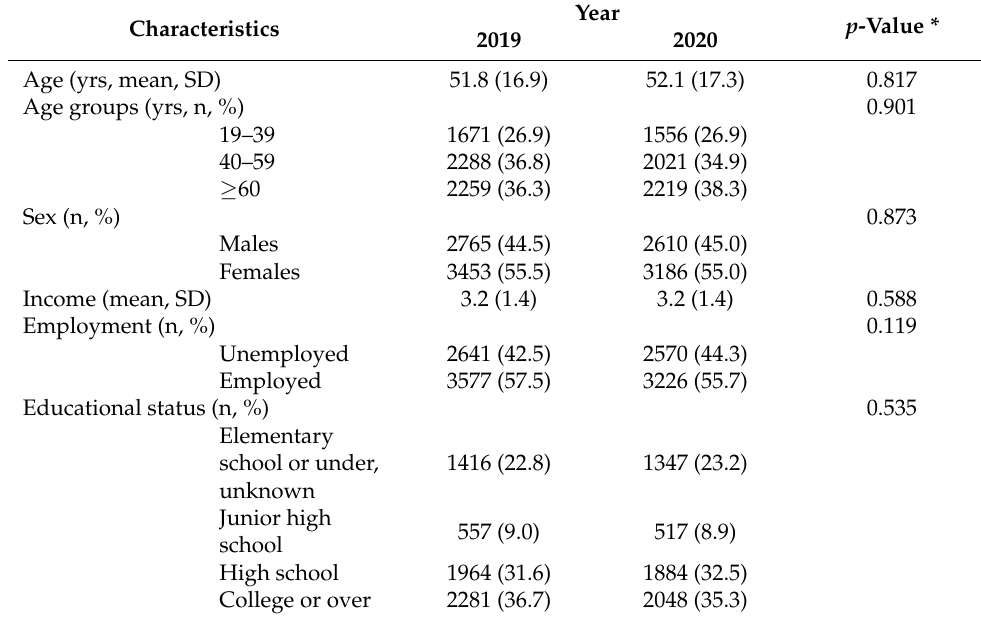
Table 1. General characteristics of